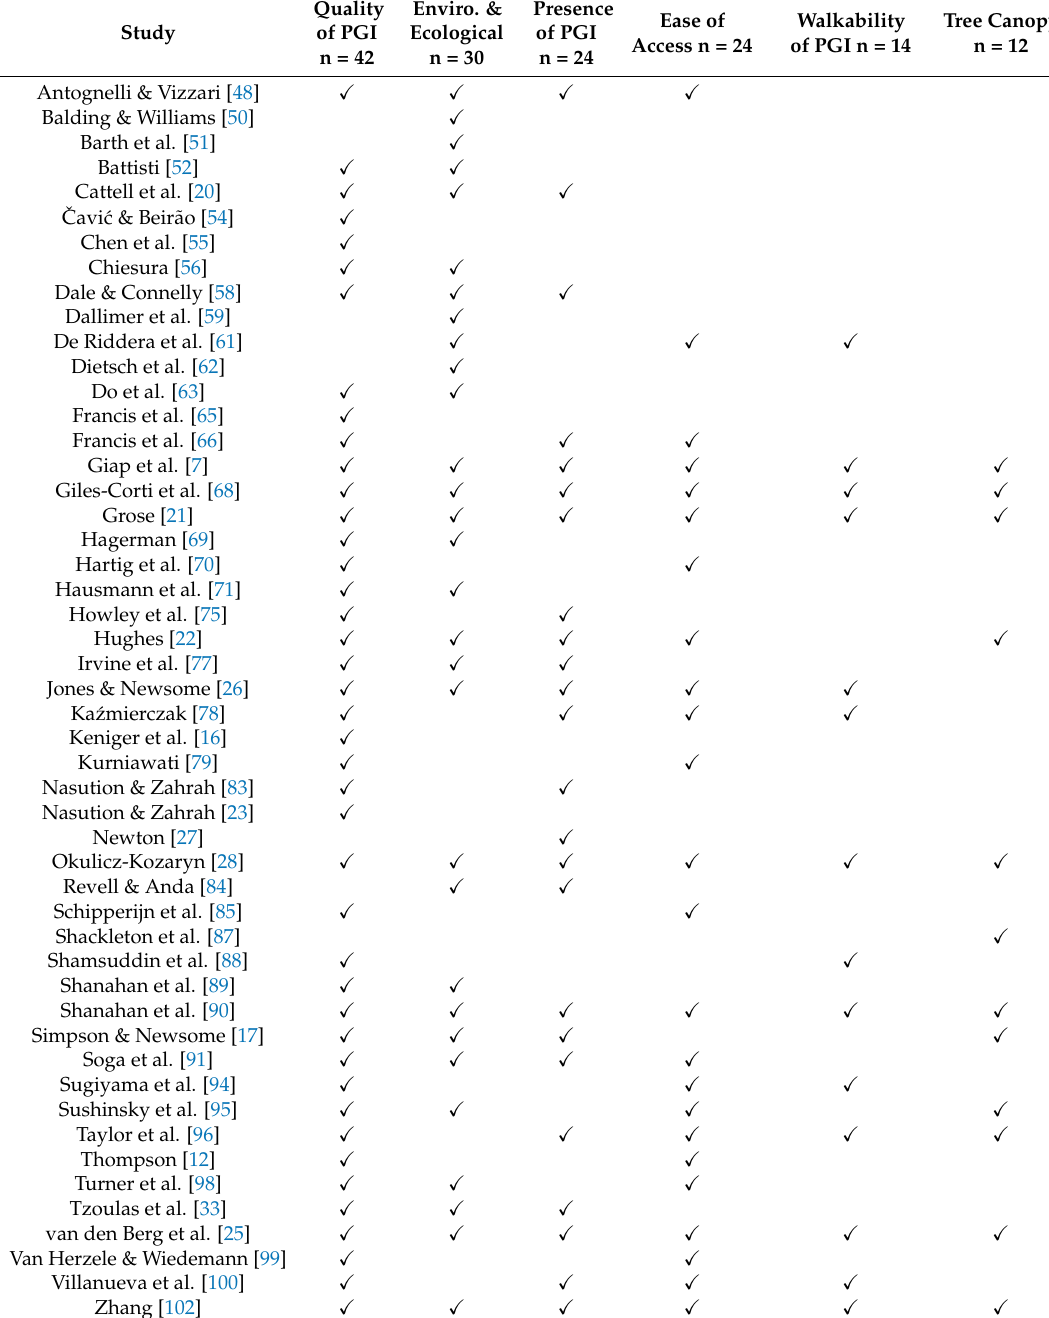
Table 7. Reporting of research into six attributes of PGI spaces that contribute to urban livability. Quality Enviro. & Study of PGI n = 42